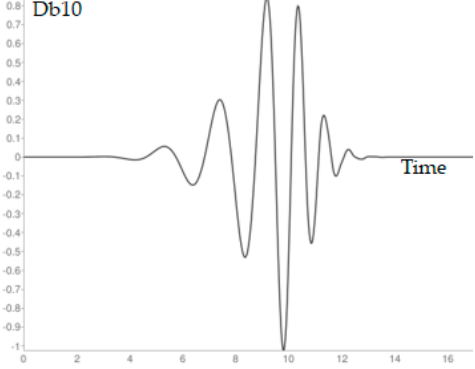
Figure 15. Daubechies 10 or Db10 wavelet used to analyze the received ultrasound signal.